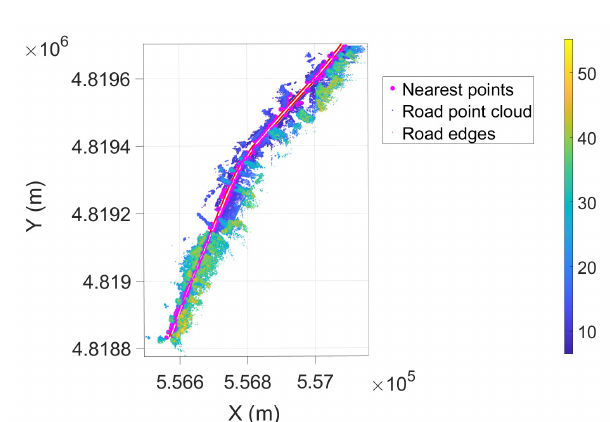
Figure 13. Vegetation detected with more than 10 m of height.